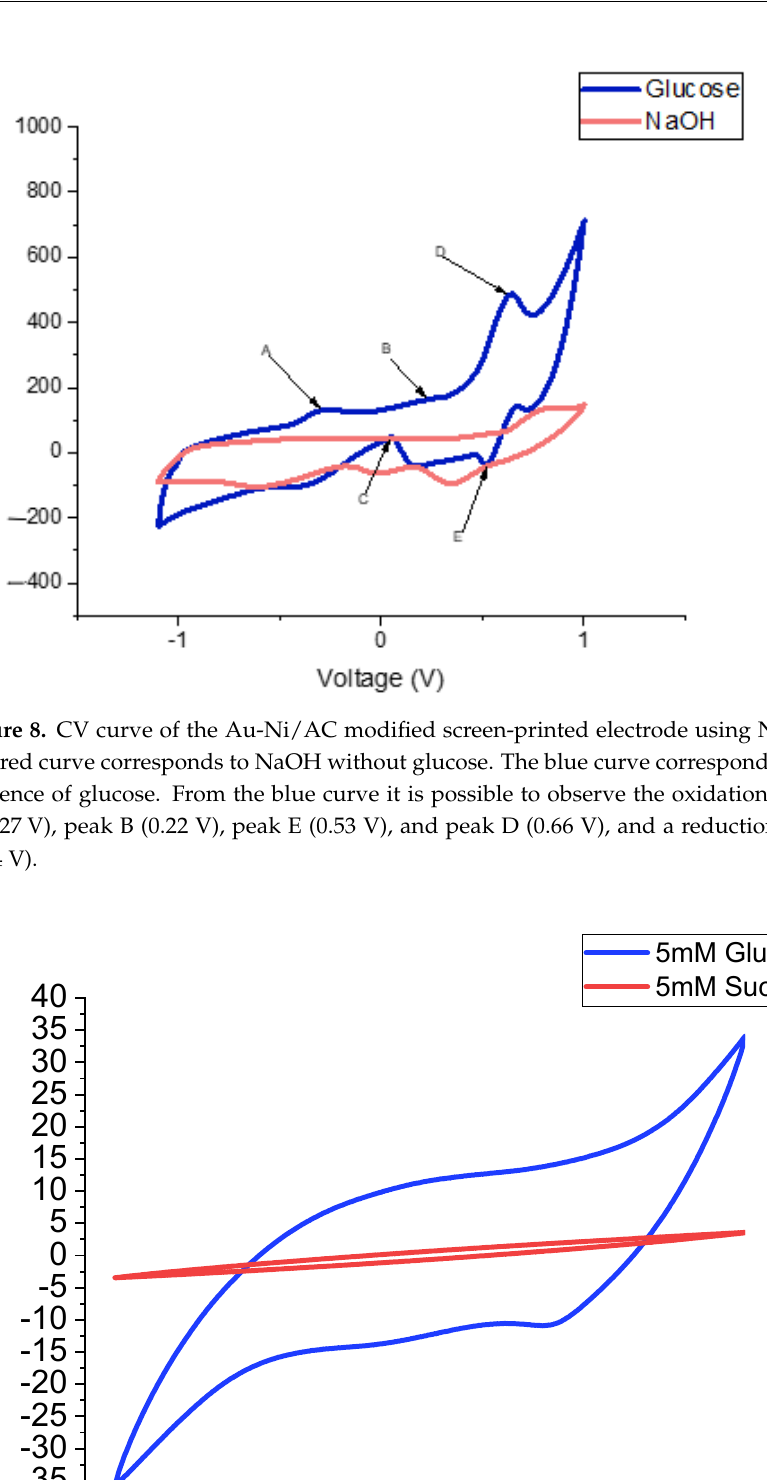
Figure 10. Current–time responses at +0.66 V with an increasing glucose concentration.